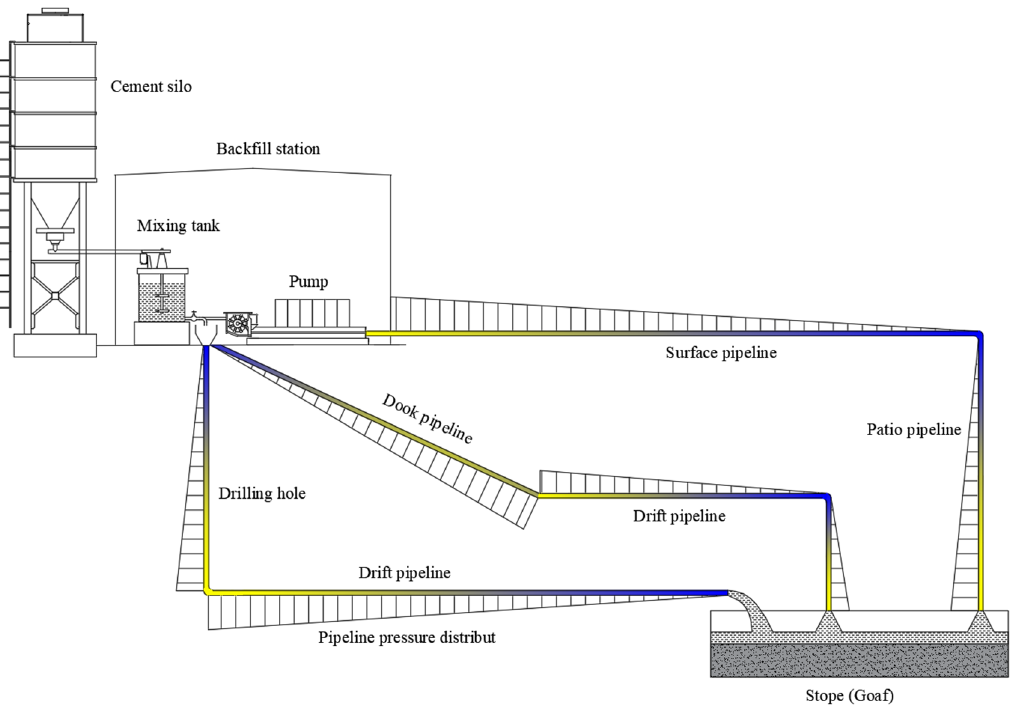
Figure 2. Common layout scheme of filling pipeline.